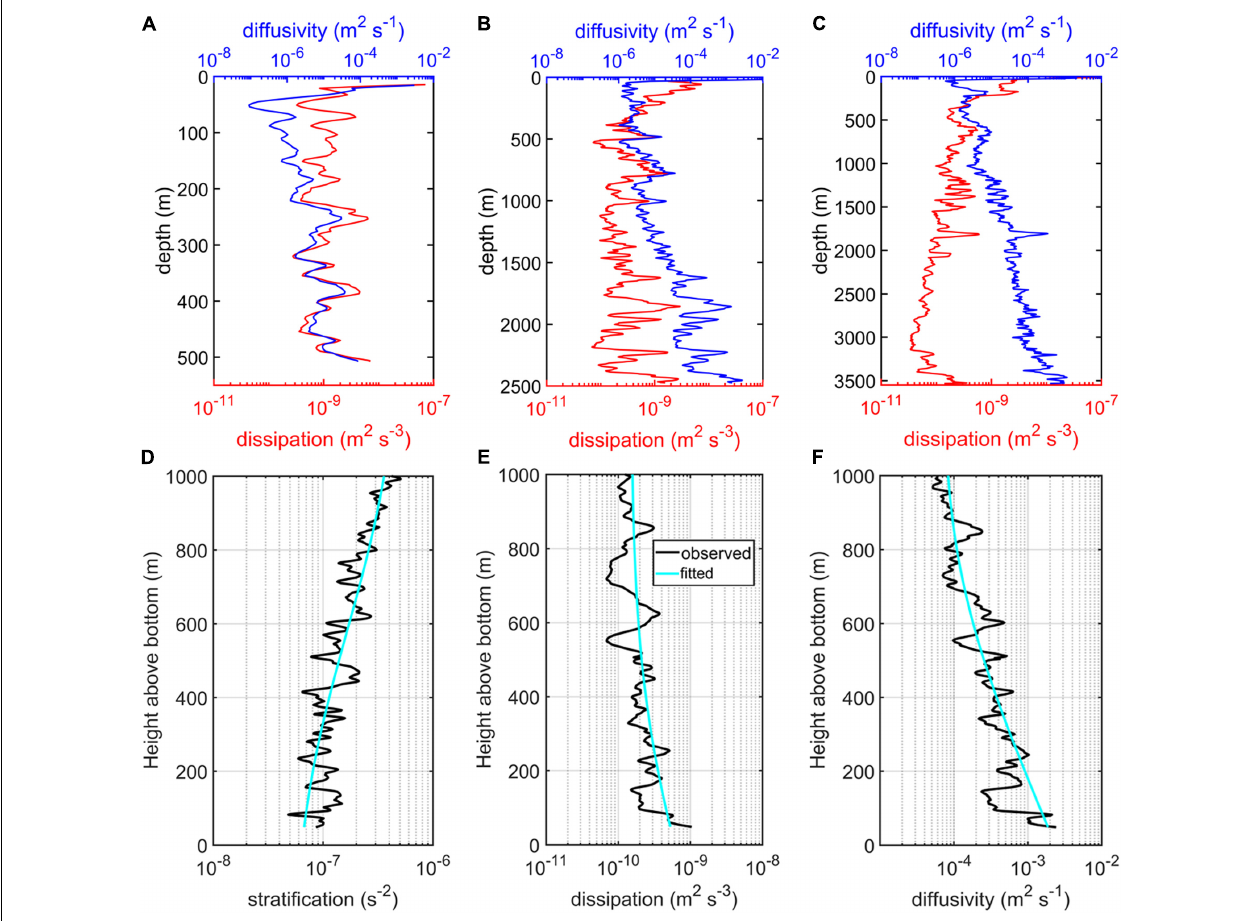
FIGURE 2 | (A–C) Full-depth turbulent dissipation profiles (red solid lines) and diffusivity profiles (blue solid lines) obtained from the VMP instruments at the seamount corresponding to the VMP stations P1, P2, and P3, respectively. (D–F) Display the height above bottom averaged stratification, turbulent dissipation, and diffusivity profile, respectively, at the seamount corresponding to the depth range below 100-m height above the bottom of two deep turbulent mixing stations. The black solid lines display the observed results and the cyan lines the fitted results.